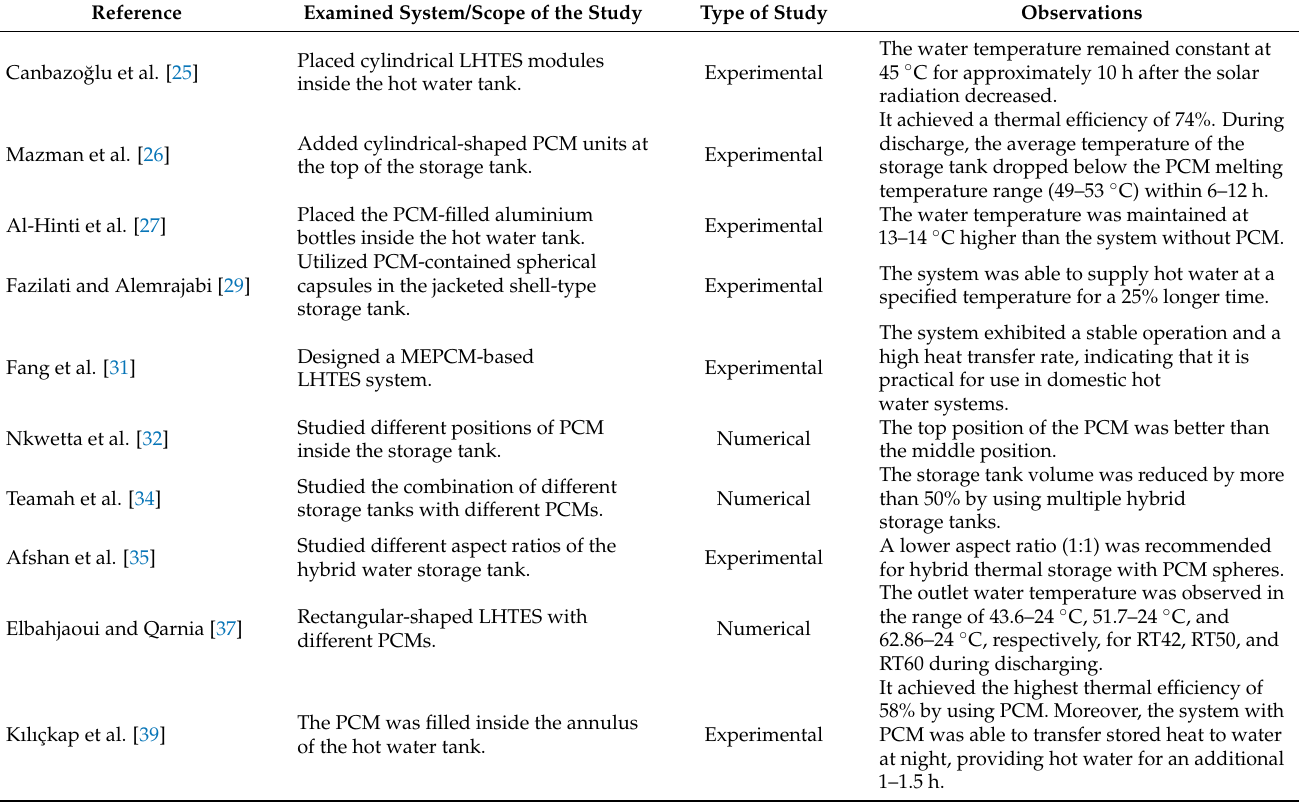
Table 2. Summary of the literature on the usage of LHTES modules inside the water storage